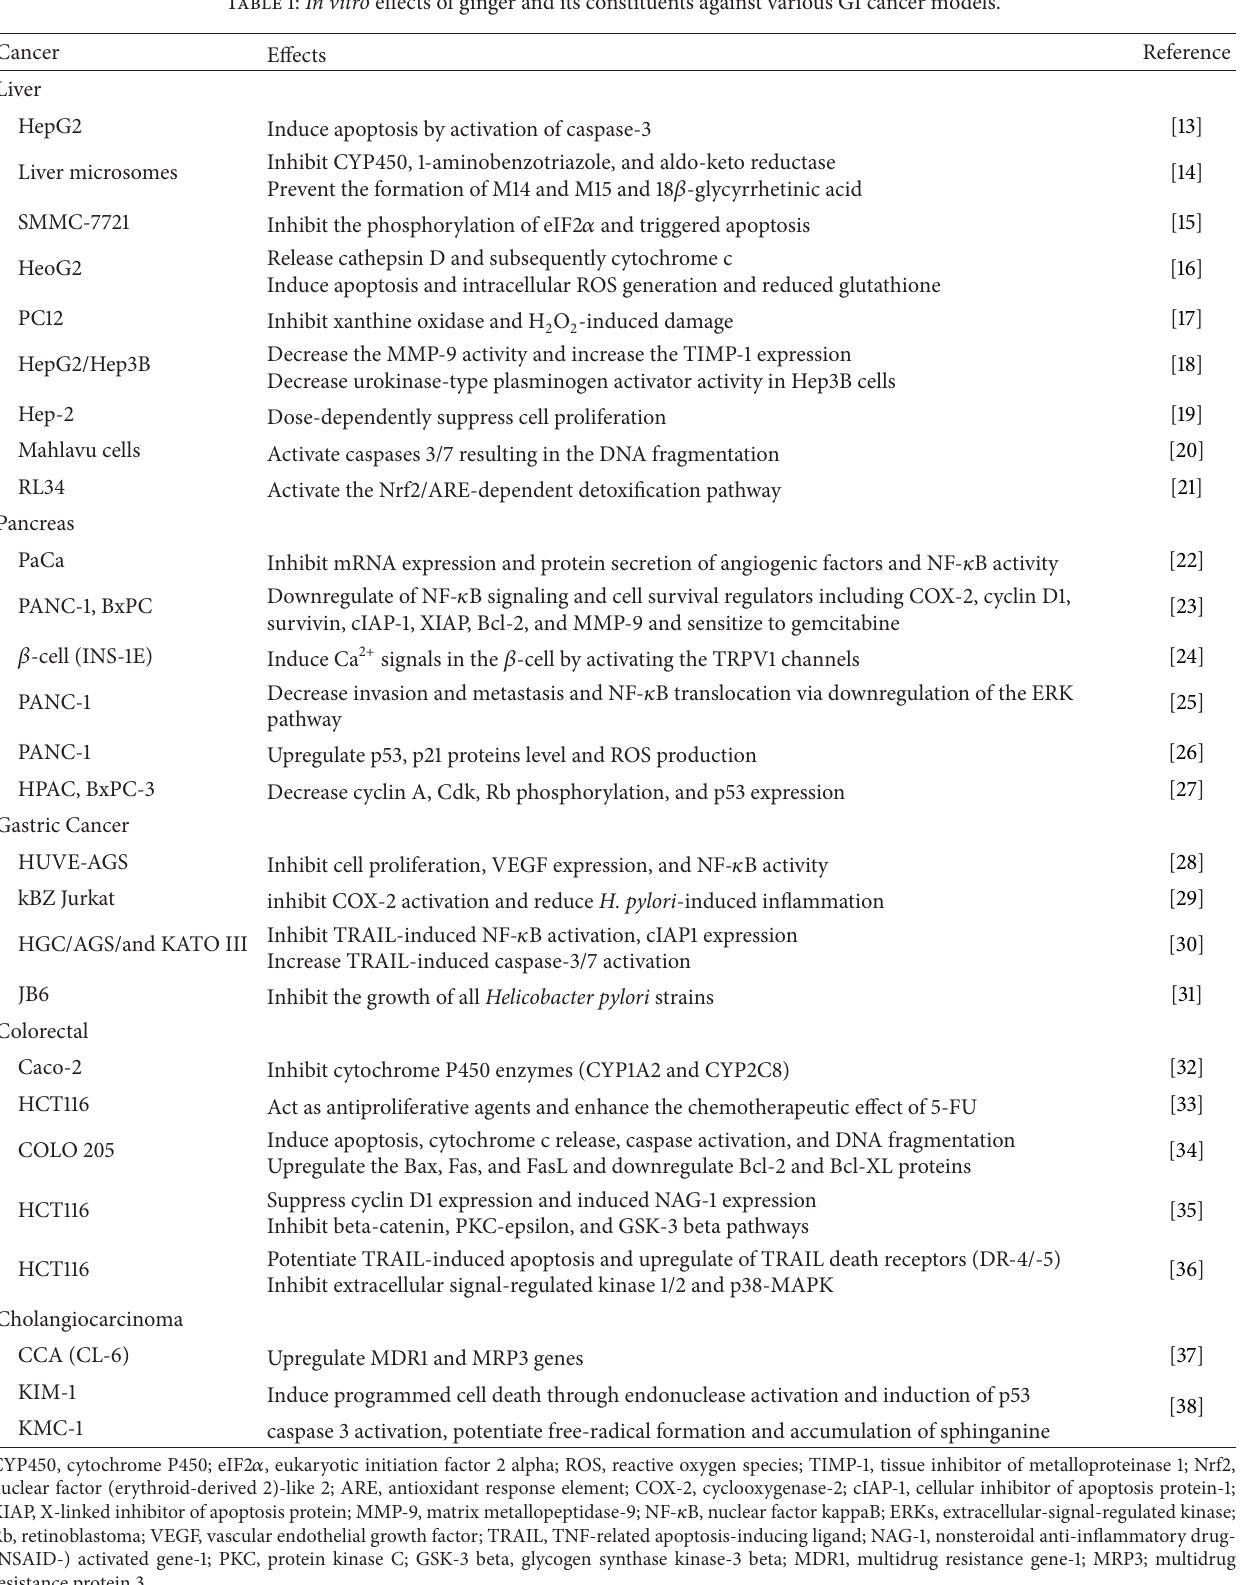
Table 1: In vitro effects of ginger and its constituents against various GI cancer